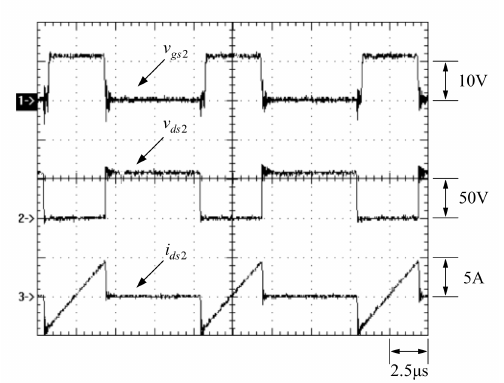
Figure 17. Experimental waveforms: (1) v gs 2 ; (2) v d s2 ; (3) i d s2 .